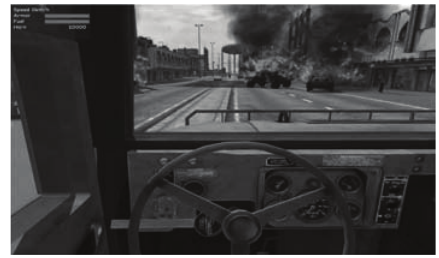
Figure 2: Serious gaming environment: high threat